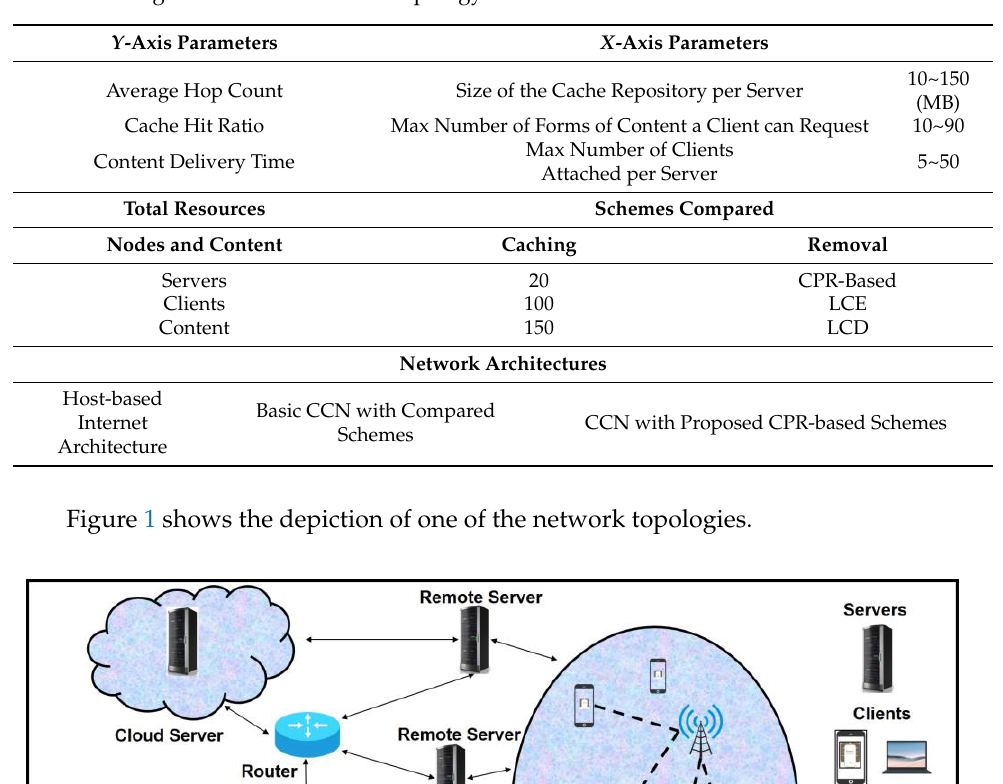
Table 1. Configuration of the network topology.